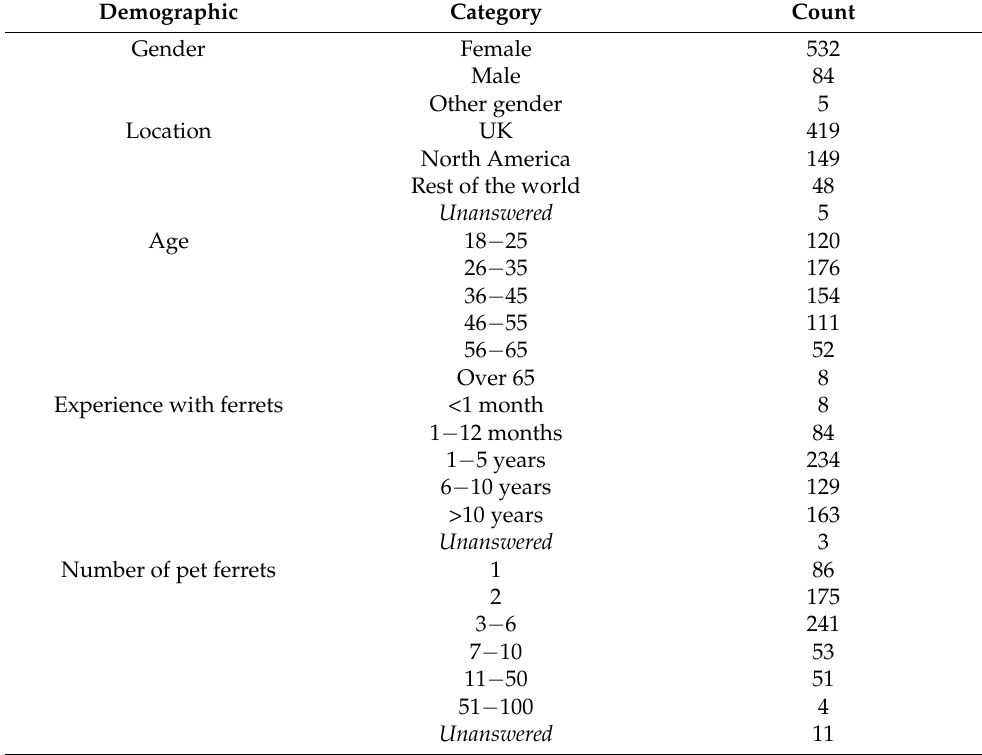
Table 2. Pet ferret owner (survey respondents) demographics, including gender, location, age, experience with ferrets, and number of pet